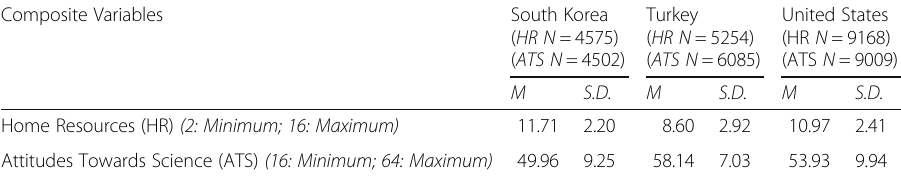
Table 5 Statistics of the composite variables for fourth graders in South Korea, Turkey, and the United States Composite